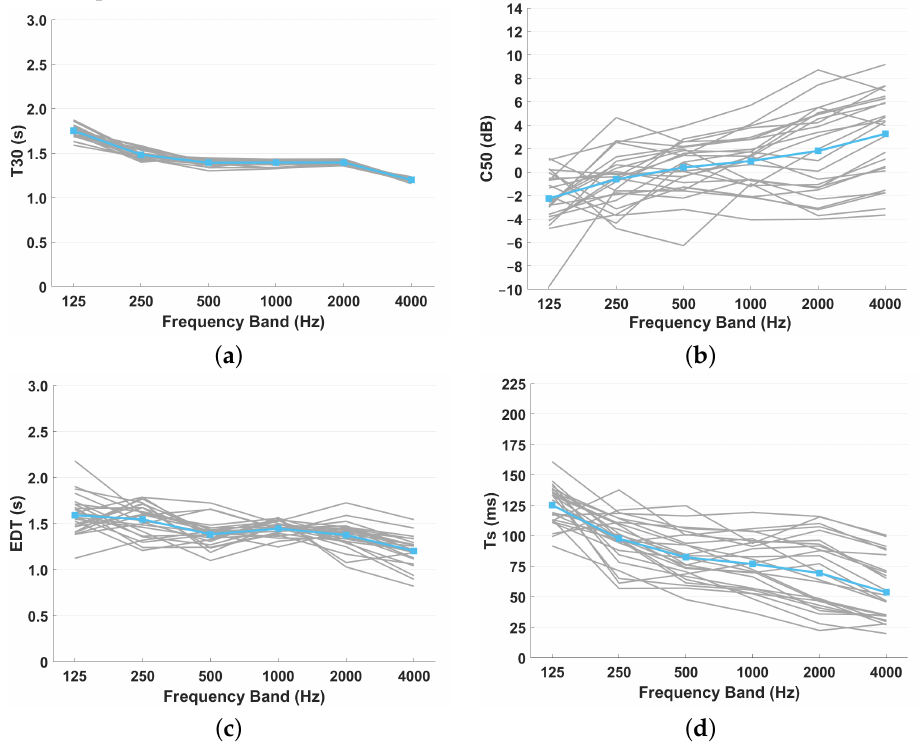
Figure 18. Results of the twenty-six individual measured positions in Holywell Music Room and the average values across frequency bands for ( a ) T30, ( b ) C50, ( c ) EDT and ( d )